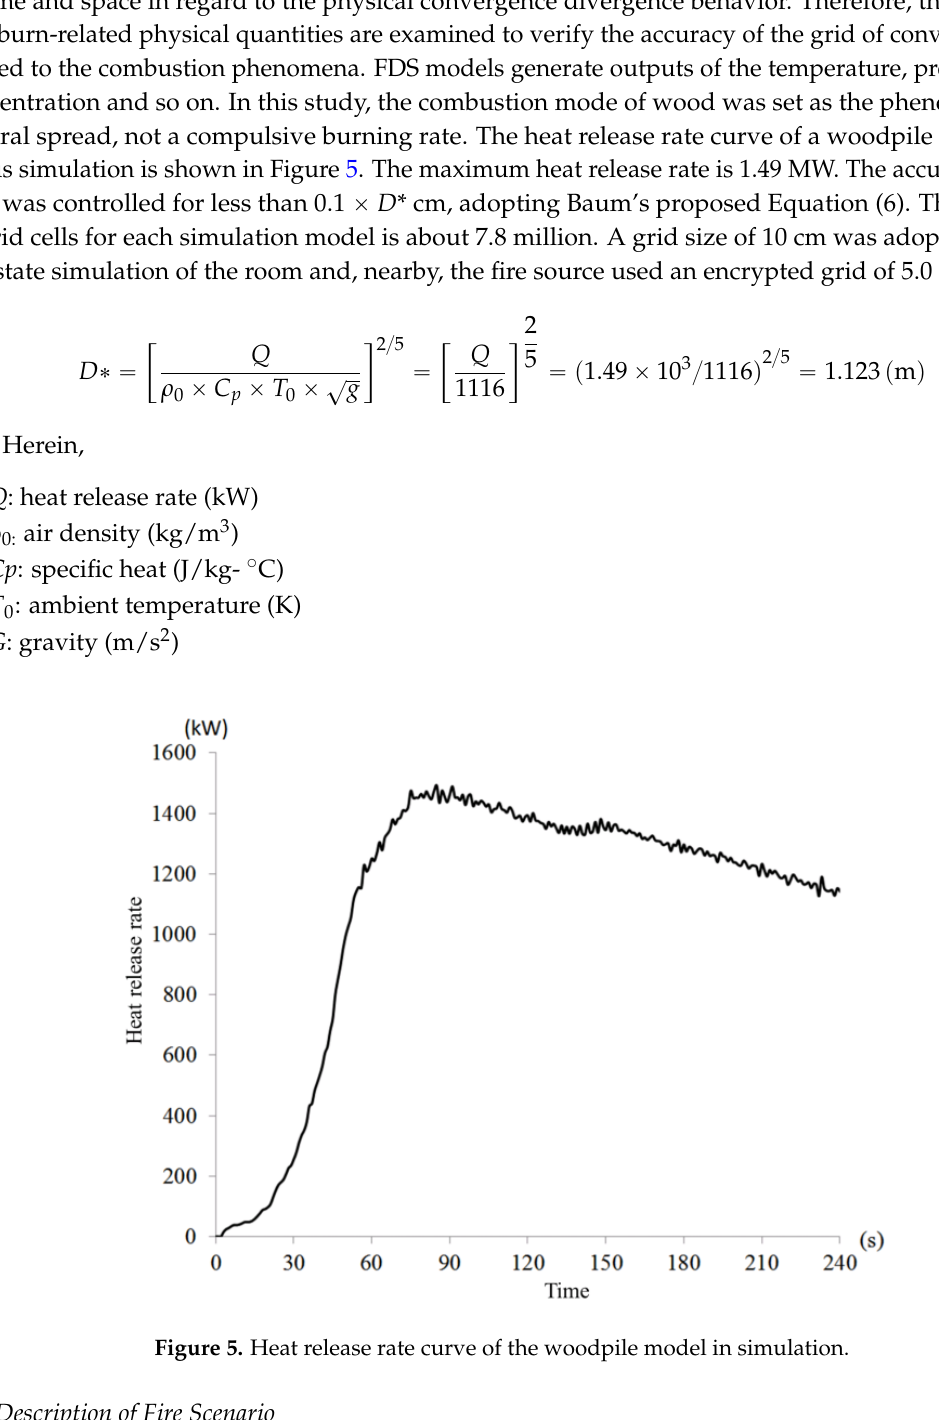
Figure 4. ( A ) The woodpile model (standard model for Fire Extinguisher Approval testing); and ( B )